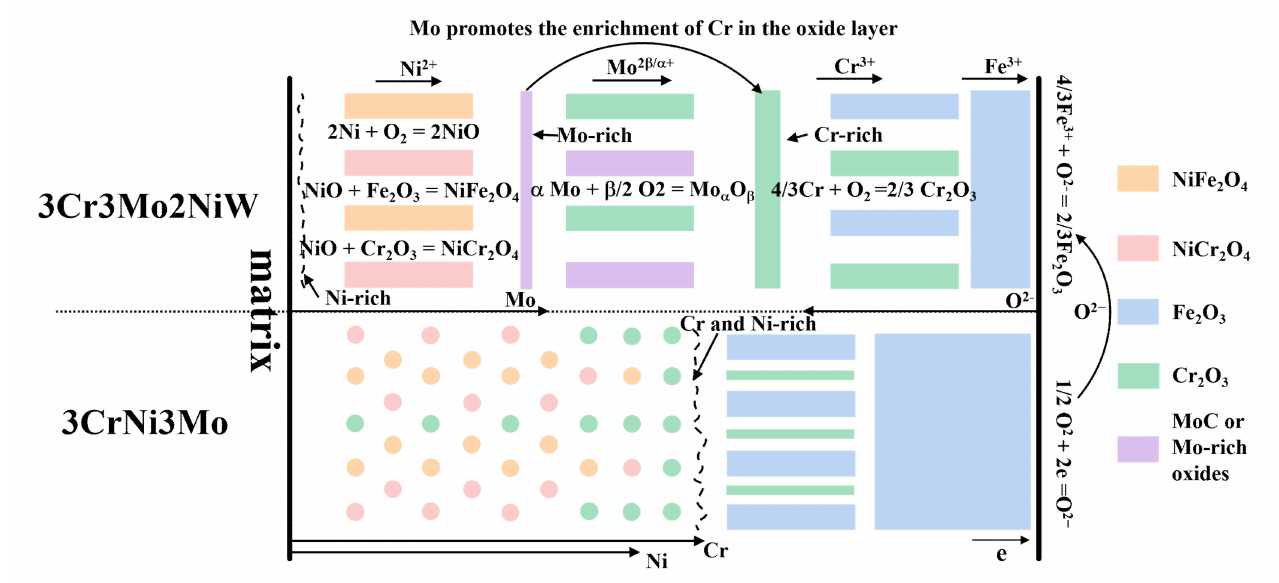
Figure 9. Schematic diagram elucidating the oxidation mechanism of two Cr-Ni-Mo hot-work die steels at 600 ◦